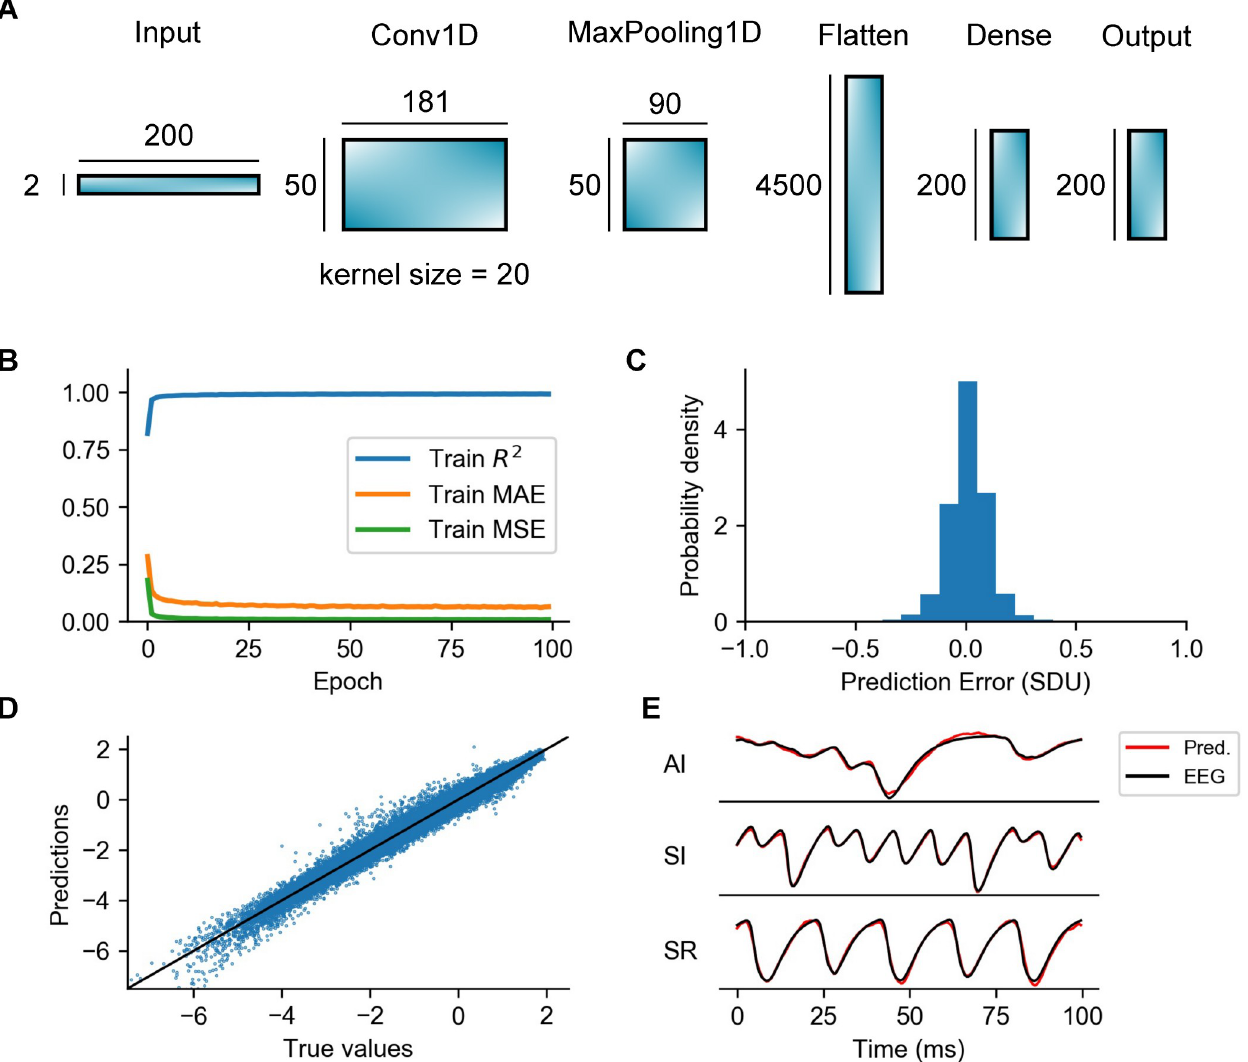
Fig 7. Overview of the convolutional neural network, train errors and accuracy of EEG predictions. (A) Illustration of the different types of layers included in the processing pipeline of the CNN architecture as well as the output shapes of each layer. Note that the 1D convolutional layer (‘Conv1D’) uses 50 filters and a 1D convolutional window (kernel) of size = 20. The total number of parameters of the entire CNN is 942450. (B) Training metrics collected during training: R 2 , Mean Absolute Error (MAE) and Mean Squared Error (MSE). (C) Probability density function of the prediction error calculated on the test dataset. The error is expressed in Standard Deviation Units (SDU) (D) Predictions vs true values. Each dot of the scatter plot corresponds to amplitude values of the predicted and real EEG signals at a specific time step of the simulation. The continuous line represents a perfect EEG estimator. (E) Examples of predictions of the CNN compared to the ground-truth EEGs for different network